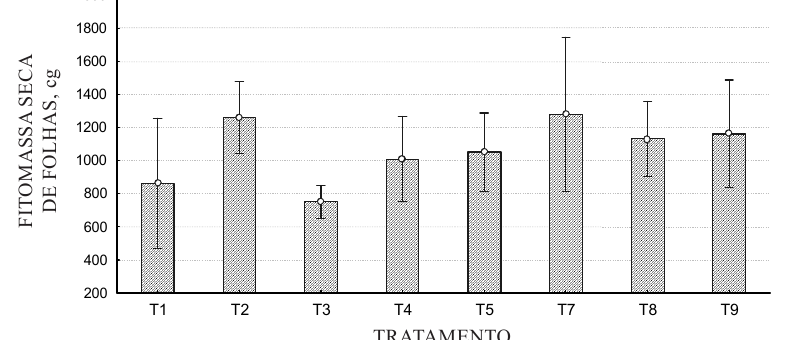
Figura 3. Média (n = 4) da produção de folhas pelo eucalipto com um ano de idade em cada tratamento. A variação é o Intervalo de Confiança calculado com 95 % de certeza. T1-testemunha; T2-adubação mineral; T3-10 t ha -1 de biossólido + K mineral; T4-20 t ha -1 de biossólido + K mineral; T5-40 t ha -1 de biossólido + K mineral; T7-40 t ha -1 de biossólido + K mineral, aplicação superficial; T8-80 t ha -1 de biossólido; T9-160 t ha -1 de biossólido.